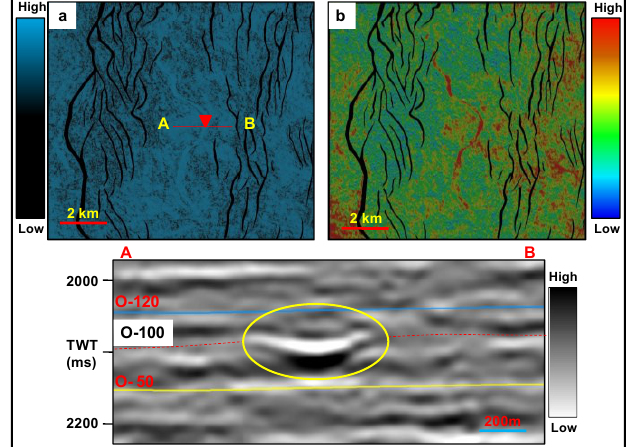
Figure 8: Dip steered similarity (a) and Spectral decomposition CWT 45 Hz (b) of horizon K-30. The seismic section along A-B shows strong amplitude at the sand position confirmed by log data. Red dot indicates well location. 3.2.3 Period 3